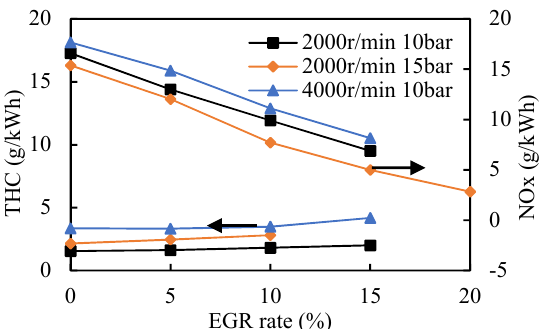
Figure 12. THC and NOx emission characteristics under different EGR rates.